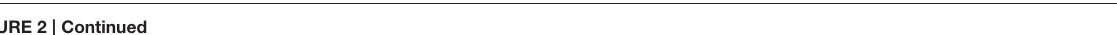
FIGURE 2 | Continued knockout and complemented strains. Three independent replications were performed. Bars indicate the standard error. The values are presented as the mean ± s.d. Differentiation was evaluated by t- test. Different letters on a graph indicate significant differences, P < 0.05. (E) Comparison of the number of conidiophores per plate of BcDIM5 knockout and complemented strains. Three independent replications were performed, P < 0.05. (F) Comparison of dry weight of sclerotia produced by BcDIM5 knockout and complemented strains. Three independent replications were performed, P < 0.05.